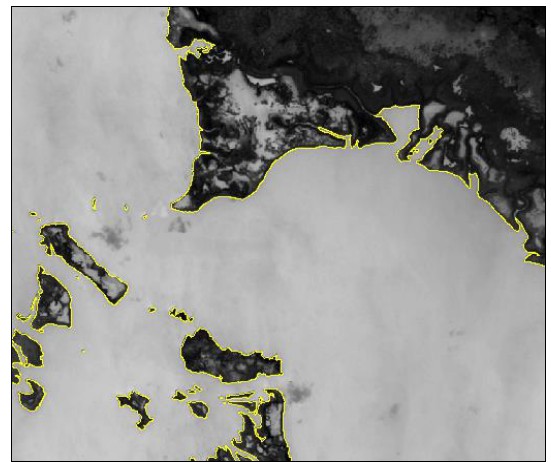
Figure 4. Zoom in to vector create over SENTINEL-2 images transformed to